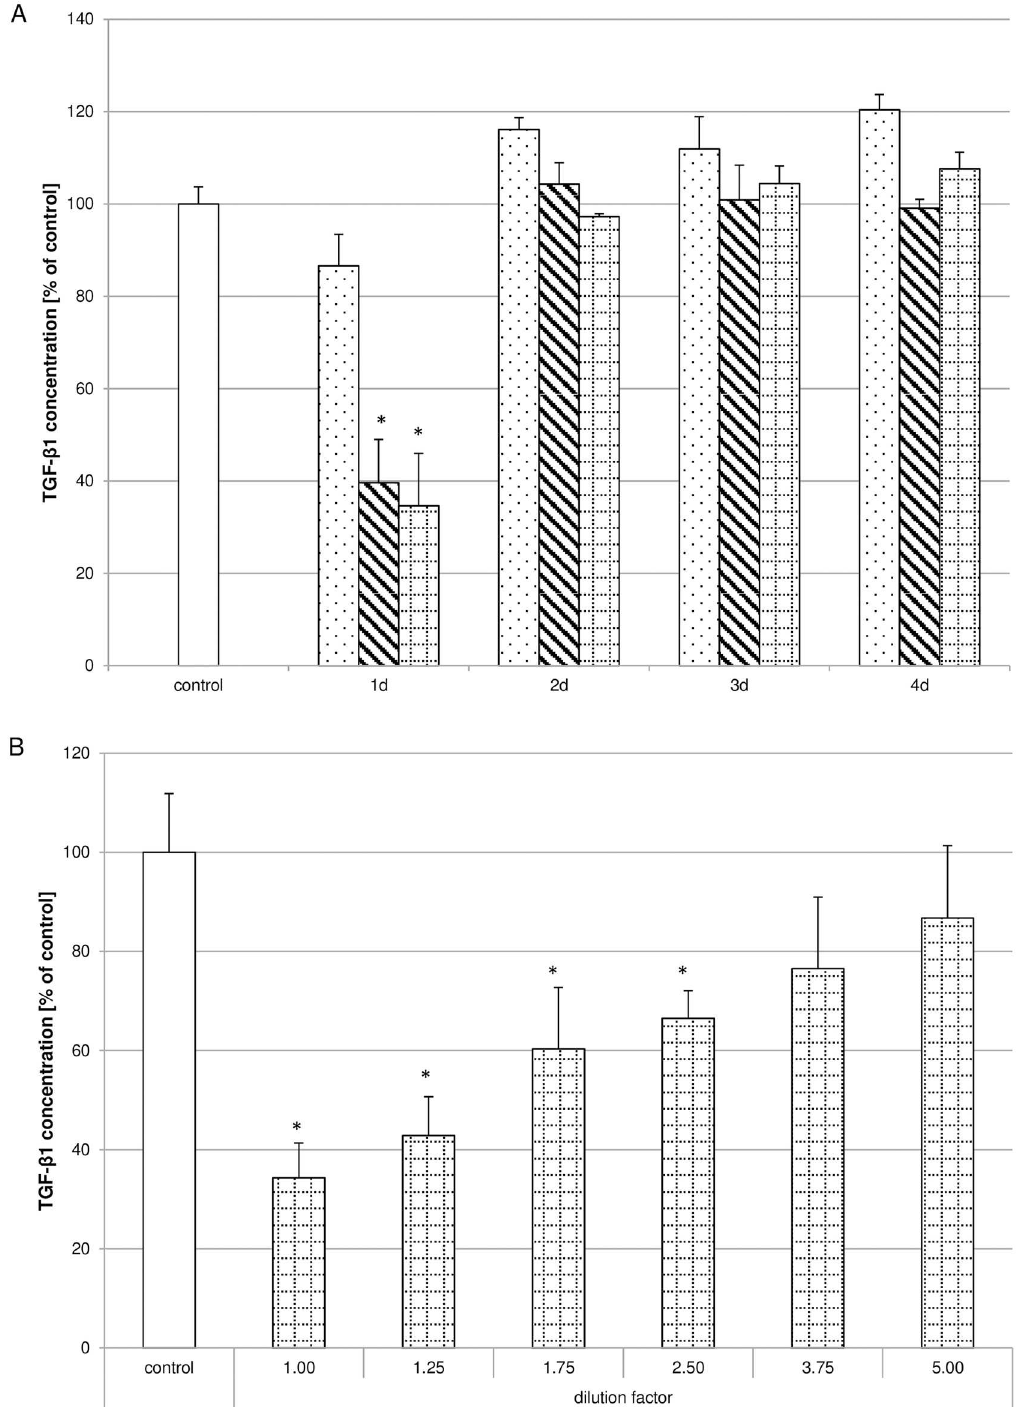
Fig 8. Biodentine ® suspensions decreasedTGF- β 1 secretion. TGF- β 1 secretion was evaluatedwith a TGF- β 1 ELISA. It could be shown that the Biodentine ® suspensions of low (dotted bar), moderate (striped bar) or high (bricked bar) Biodentine ® concentrations of day 1 reducedthe TGF- β 1 secretion in a concentration dependent way (A; N = 180) in comparisonto the control (white bar). Serial dilutionsof the high Biodentine ® concentrations containing suspensions of day 1 substantiated the concentration dependentTGF- β 1 secretioninhibition(B; N = 84). The data displayedare representative of three independentexperiments that were performed with comparable results. Average absorbance values (mean ± SD) from n = 4 replicatesper experimental conditionwere calculated. * p (cid:20) 0.05.